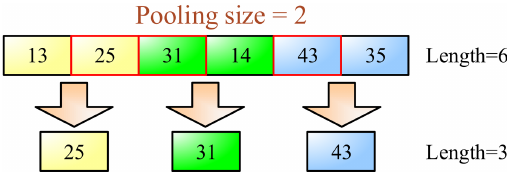
Figure 4. 1D max pooling